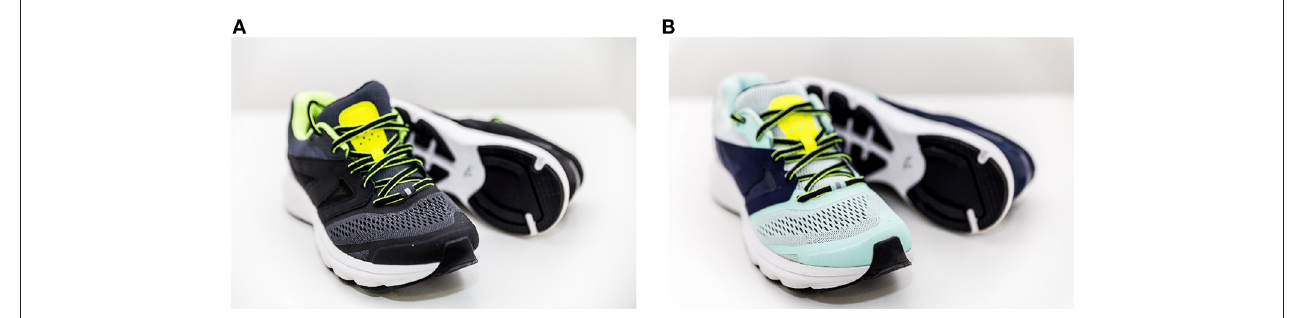
FIGURE 1 | Study shoes for men (A) and women (B)